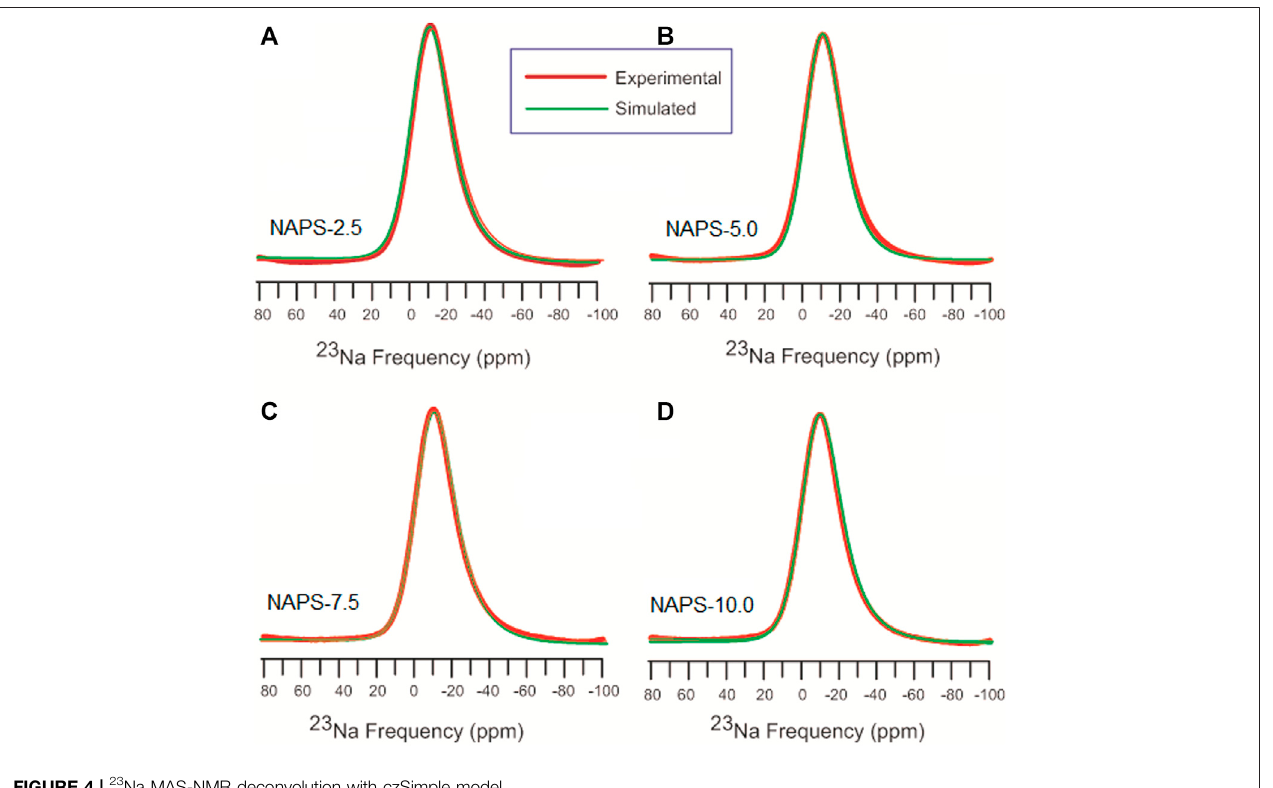
FIGURE 4 | 23 Na MAS-NMR deconvolution with czSimple model.